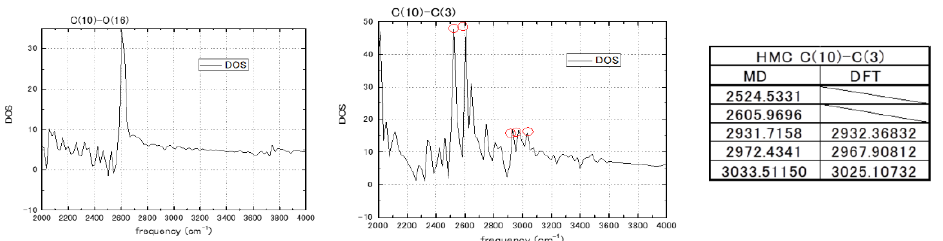
Figure 5. Spectral frequencies of the C(10)-C(3) and C(10)-O(16) bonds of hydroxymethylcytosine (HMC) (see Figure 3) calculated by MD outside of graphene pore (v z = 0) for the 2000–4000 cm − 1 frequency region. Comparison to the density functional theory (DFT) calculations of Raman frequencies.